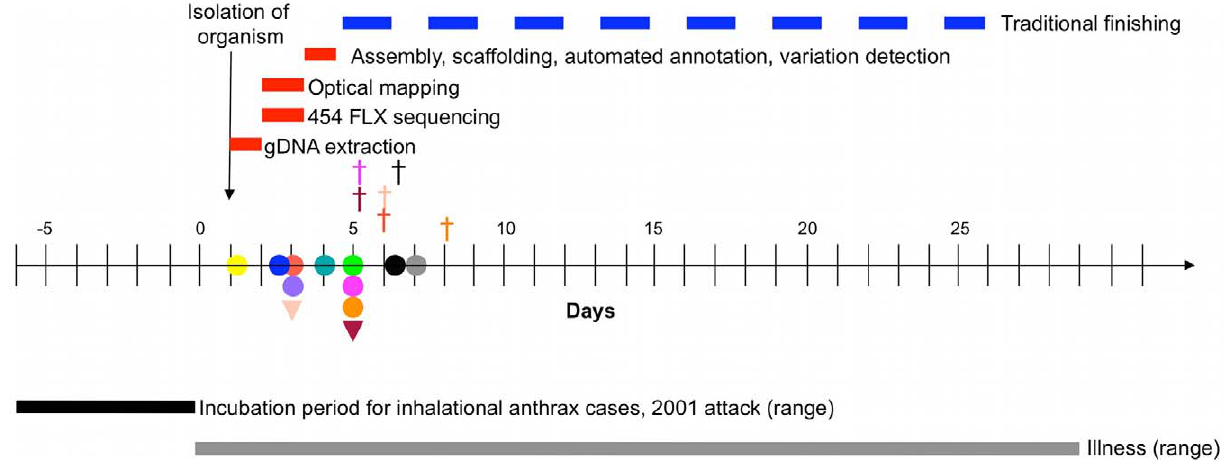
Figure 1. Estimated timelines of WGS and finishing in relation to anthrax disease progression in anthrax cases. The anthrax disease progression and the results of antibiotic treatment in the first ten cases of the 2001 anthrax letter attack [13] and two cases of anthrax-like disease caused by B. cereus in 1996 [14]. Colored circles indicate when individual cases of inhalational anthrax from 2001 attack were started on antibiotic therapy and colored triangles indicate when 1996 B. cereus fatal pneumonia cases resembling anthrax were started on antibiotic therapy. The crosses indicate the time of death of 6 of the 12 patients. The bars in the top part of the top panel indicate the estimated timelines involved in obtaining WGS sequencing from the time the patient seeks medical care. Currently, there is no standard protocol or fixed time frame for genome finishing and the process varies from a few months to years depending on the complexity of the genome and approaches used.